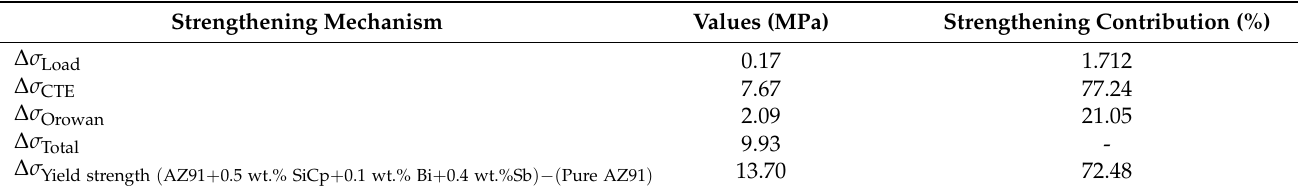
Table 8. Percentage of strengthening contribution and comparison of the yield strengths of pure AZ91 and the as-cast AZ91 + 0.5 wt.% SiCp + 1 wt.% Sb + 0.4 wt.% Sb matrix. Strengthening Mechanism Values (MPa) Strengthening Contribution (%) ∆ σ Load ∆ σ CTE ∆ σ Orowan ∆ σ Total ∆ σ Yield strength ( AZ91 + 0.5 wt.% SiCp + 0.1 wt.% Bi + 0.4 wt.%Sb ) − ( Pure AZ91